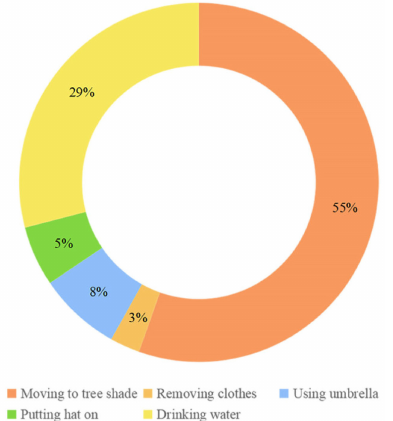
Figure 11. The frequency distribution of thermal adaptive